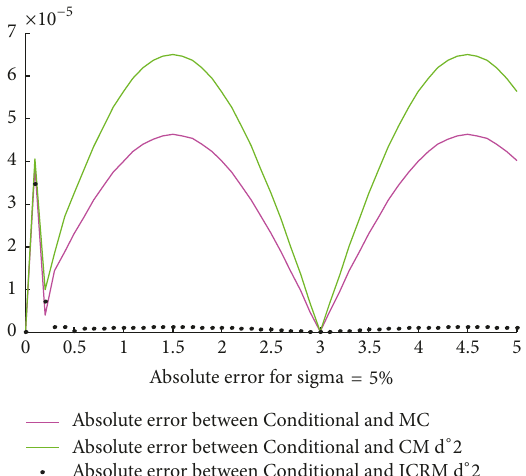
Figure 9: Absolute error between PC of degree 2 and IRCM of degree 2 MC (2000) and reference methods where 𝜉 0 and 𝜉 2 are truncated normal variables in [−4, 4] , 𝜉 1 is a uniform variable in [−1,1] , and 𝜉 3 is a truncated exponential variable in [0,10] and 𝜎 𝑖 =